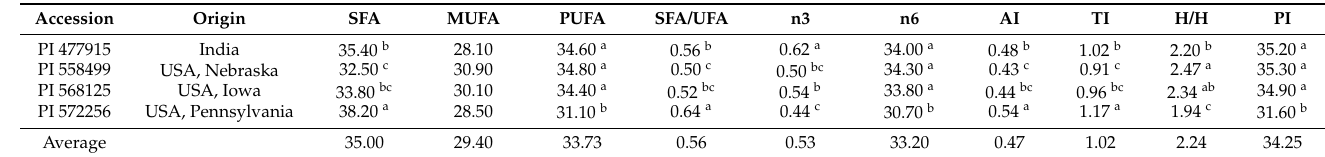
Table 4. Mean values of three replications of fatty acid classes (g/100 g) *, ratios and quality indices in the four accessions of A. hypochondriacus seed.